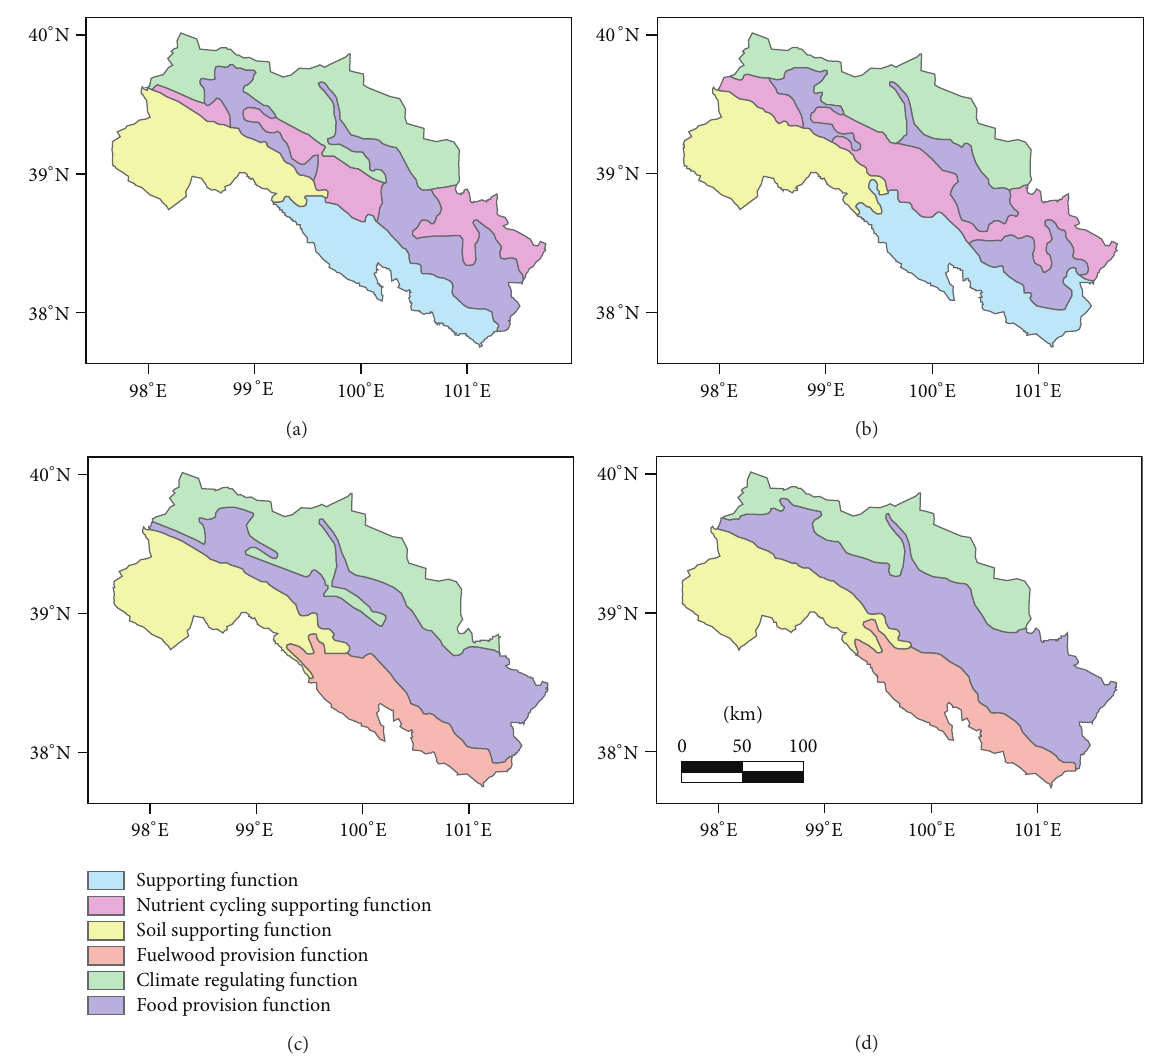
Figure 6: Ecosystem service zoning of middle reaches of the HRB in the years of (a) 1988, (b) 1995, (c) 2000, and (d) 2008.